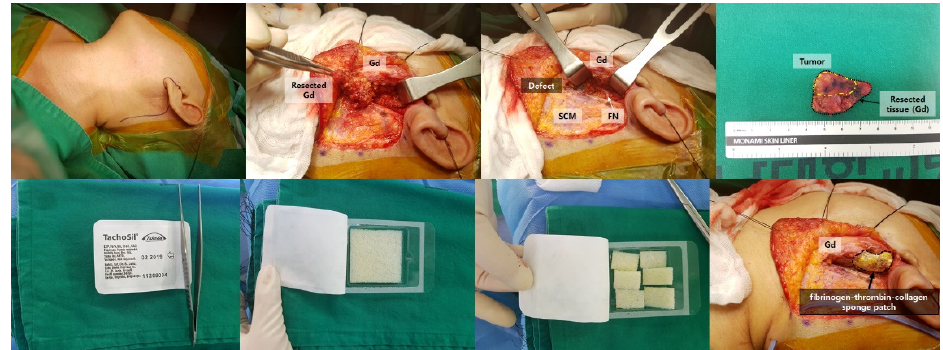
Figure 2. Operative procedure of the patients in the fibrinogen-thrombin-collagen sponge patch group. After superficial parotidectomy was performed using a conventional parotid surgery technique (tunnel technique), a ready-to-use fibrinogen-thrombin-collagen sponge patch (4.8 cm × 4.8 cm × 0.5 cm), was moistened in normal saline and applied to the cut surface of the parotid gland with at least 1 min of manual compression. FN, facial nerve; Gd, gland; SCM, sternocleidomastoid muscle.